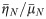
Case IV: experiments on signals of cases II and III with imposed additive Gaussian noise.We consider noise levels at 5% and 10% of the standard deviation of the original signals in cases II and III. (a) Δρ at L = 500 as a function of η¯N/μ¯N for signals of case II. (b) Δρ at L = 500 as a function of η¯N/μ¯Wb for signals of case III. Δρ = 0 and η¯N/μ¯N=1 are shown by dashed, bold lines.